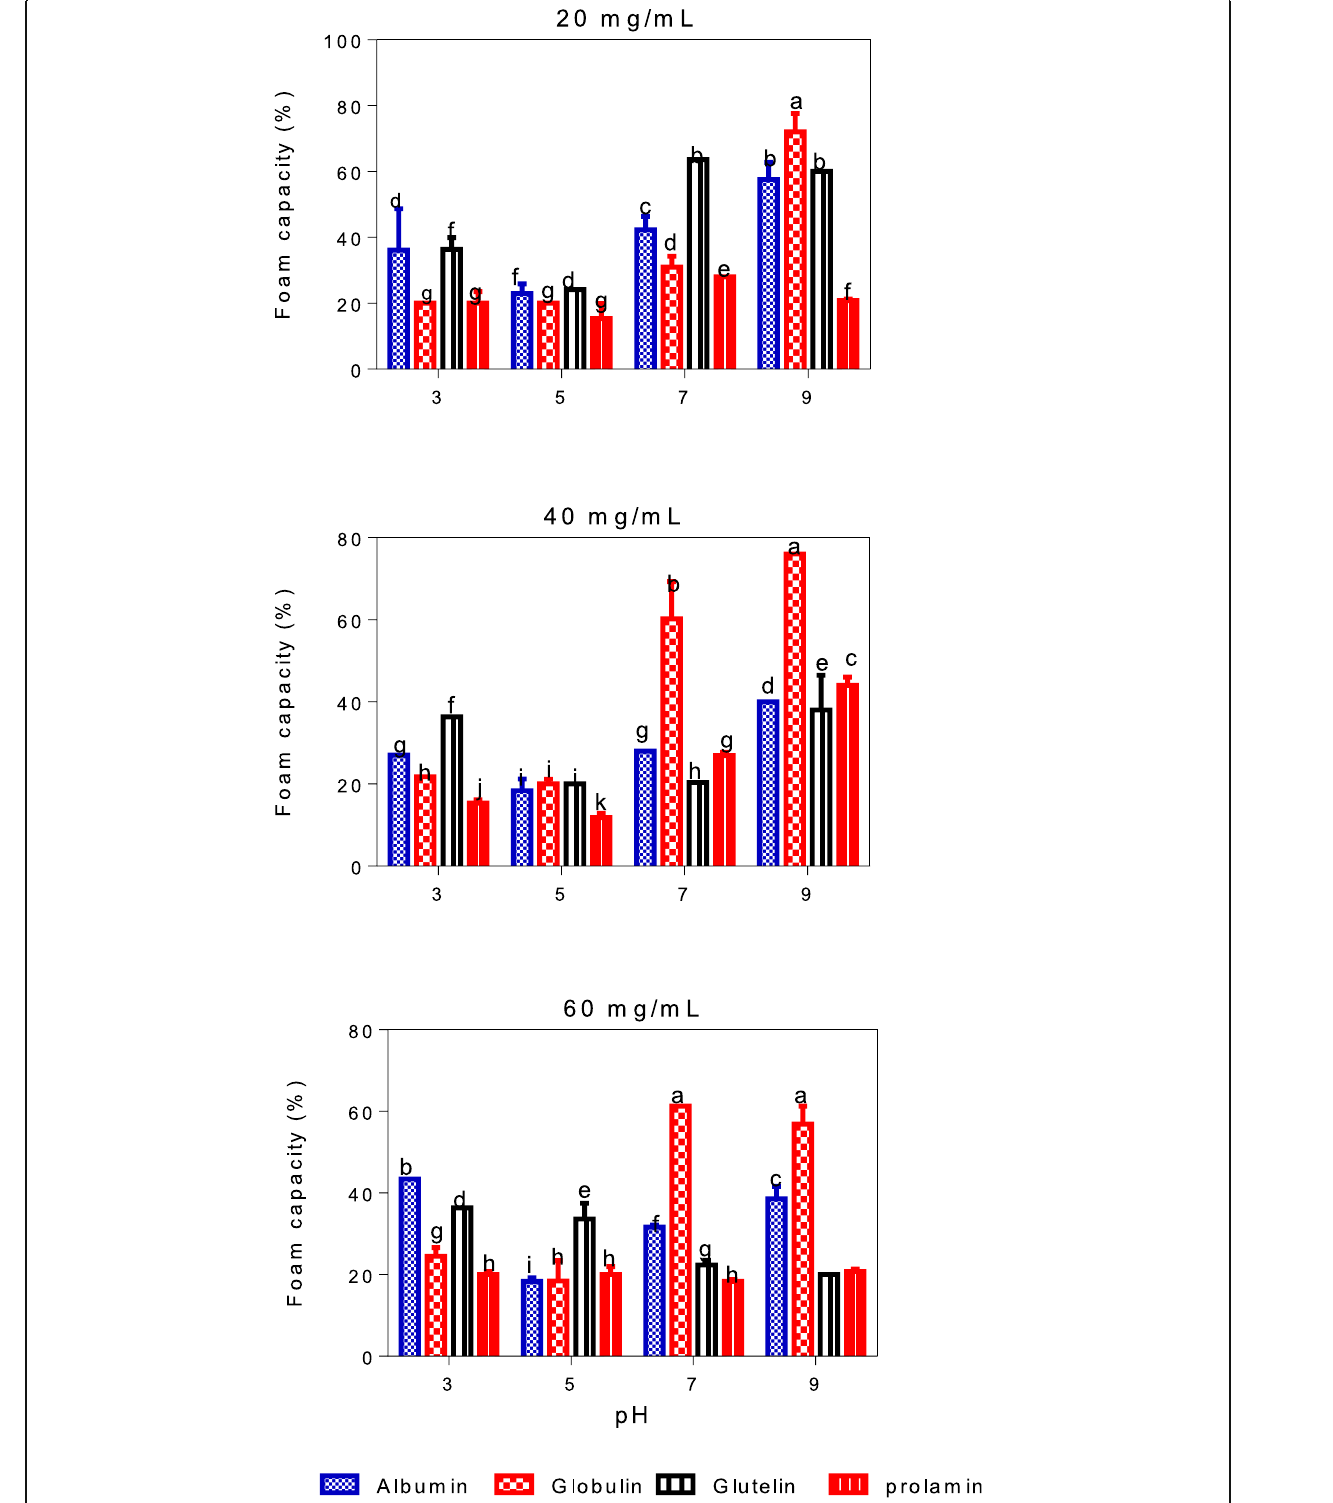
Fig. 5 Effect of pH and protein concentration on foaming capacity of sesame protein